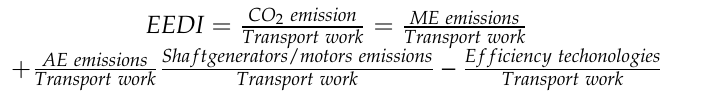
Figure 17. Share of different transportation modes in Greenhouse Gas (GHG) emissions in the European Union (EU), source [24].